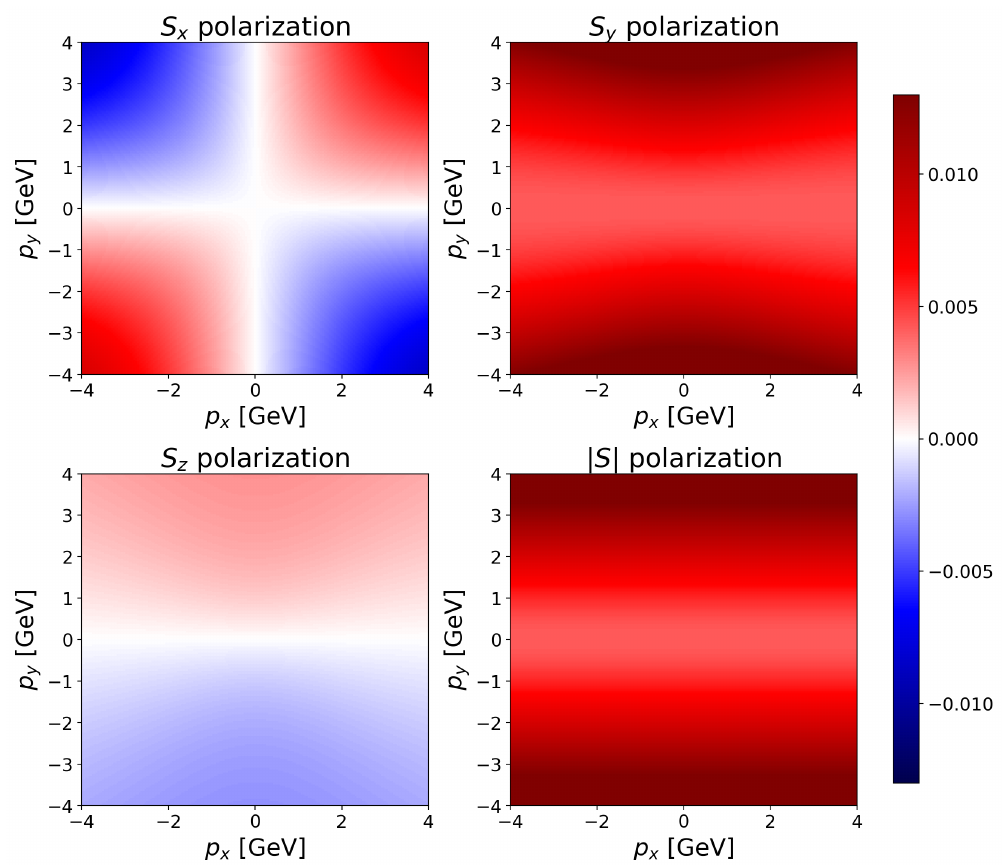
Figure 1. The components of the polarization four-vector in the rotating and accelerating expanding solution with respect to the momentum. Plots were made with the mass of the Λ baryon ( m Λ = 1115 MeV/ c 2 ), and with | Ω | = 0.1 c